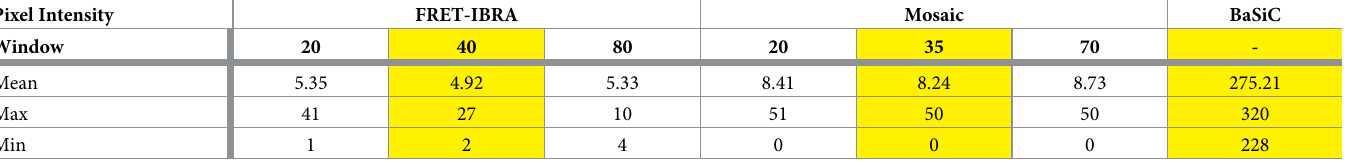
Table 1. Pixel intensity statistics after running background subtraction algorithm with variable window sizes. The window size in FRET-IBRA defines the number of tiles the image width should be divided into, i.e., for a 640x480 pixel image, a window size set at 40 results in 40 windows along the width and 30 windows along the height (1200 windows with a tile size of 16x16 pixels). The window size cannot be set for BaSiC. Parameters used for our comparison are marked yellow. Pixel Intensity FRET-IBRA Mosaic BaSiC